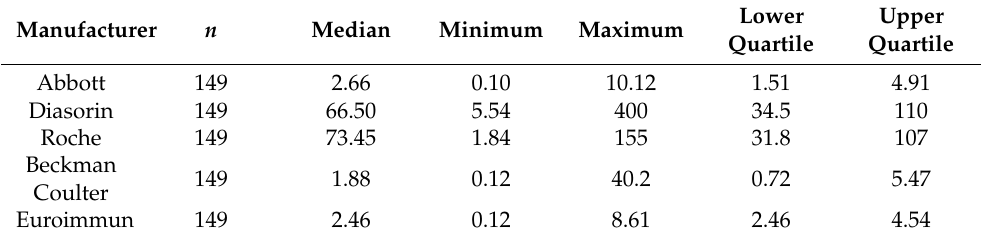
Table 3. Summary of the results of individual immunoassays used.